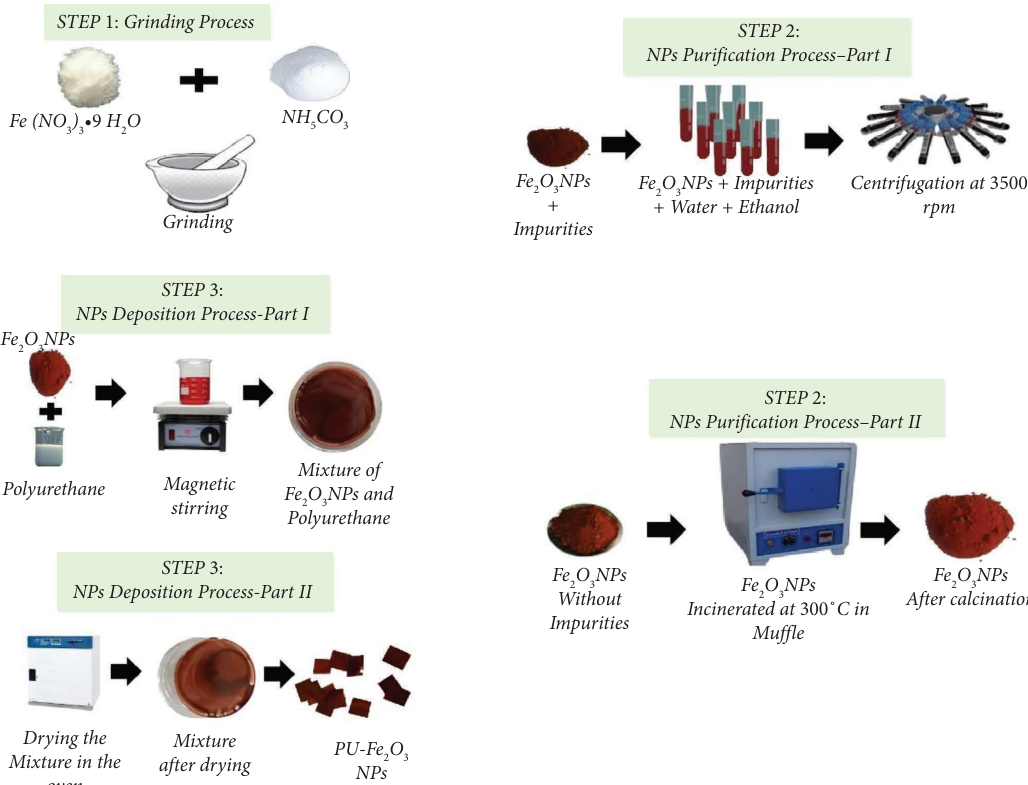
Figure 1: Synthesis of Fe 2 O 3 nanoparticles and PU-Fe 2 O 3